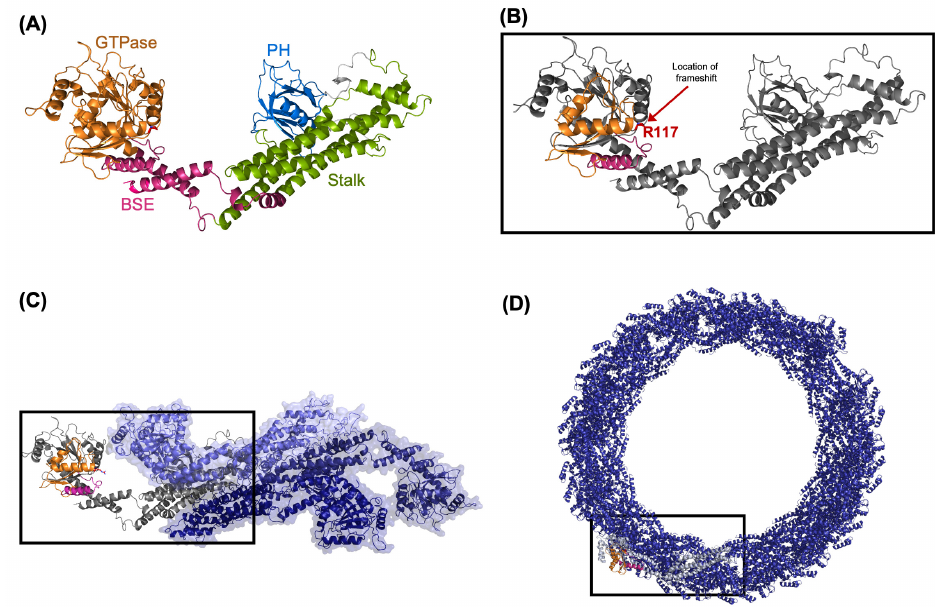
Figure 2. Molecular environment and effect of the Pro 117 Arg fs*14 mutation on the GTPase domain. ( A ) Cartoon diagram of dynamin 1 based on the crystal structure of dynamin 3 (PDB 5A3F) with the GTPase domain shown in orange, the bundle signaling element (BSE) shown in pink, the stalk domain shown in green, and the pleckstrin homology (PH) domain shown in blue. ( B ) Diagram of the effect of the Pro117Argfs*14 mutation, with the deleted portion of the protein highlighted in gray. The substituted Proline (R117) is shown as a red stick. ( C ) Location of the variant within the homology model of tetrameric dynamin 1 based on the crystal structure of dynamin 3 (PDB 5A3F). ( D ) Location of the variant within the cryo-EM structure of multimeric dynamin 1 (PDB 7AX3).